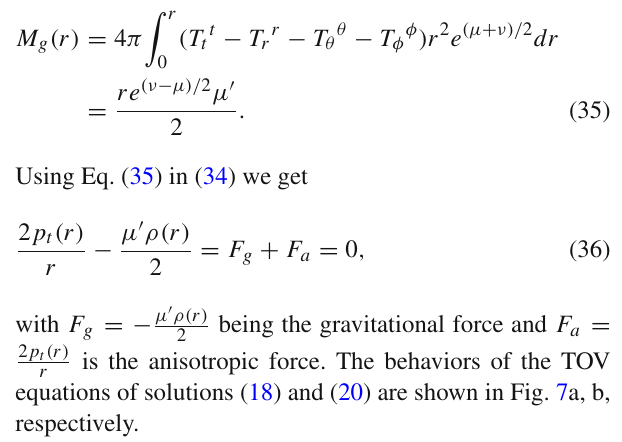
Fig. 5 Speed of sound of (20) against r in km when b 0 = 0 . 0001 and b 1 = 0 . 01